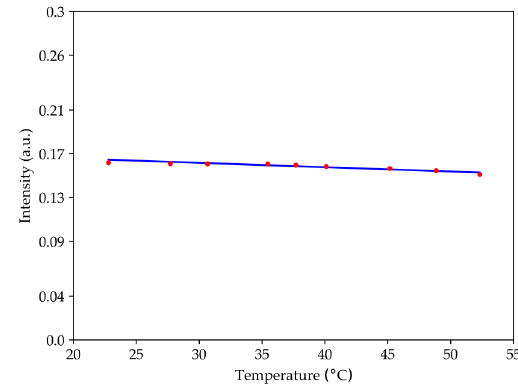
Figure 9. Optical signal intensity as a function of temperature for the wavelength of 1570 nm.